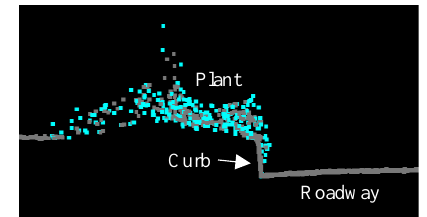
Figure 5. Removal of irregular points. Cyan point is an irregular point.